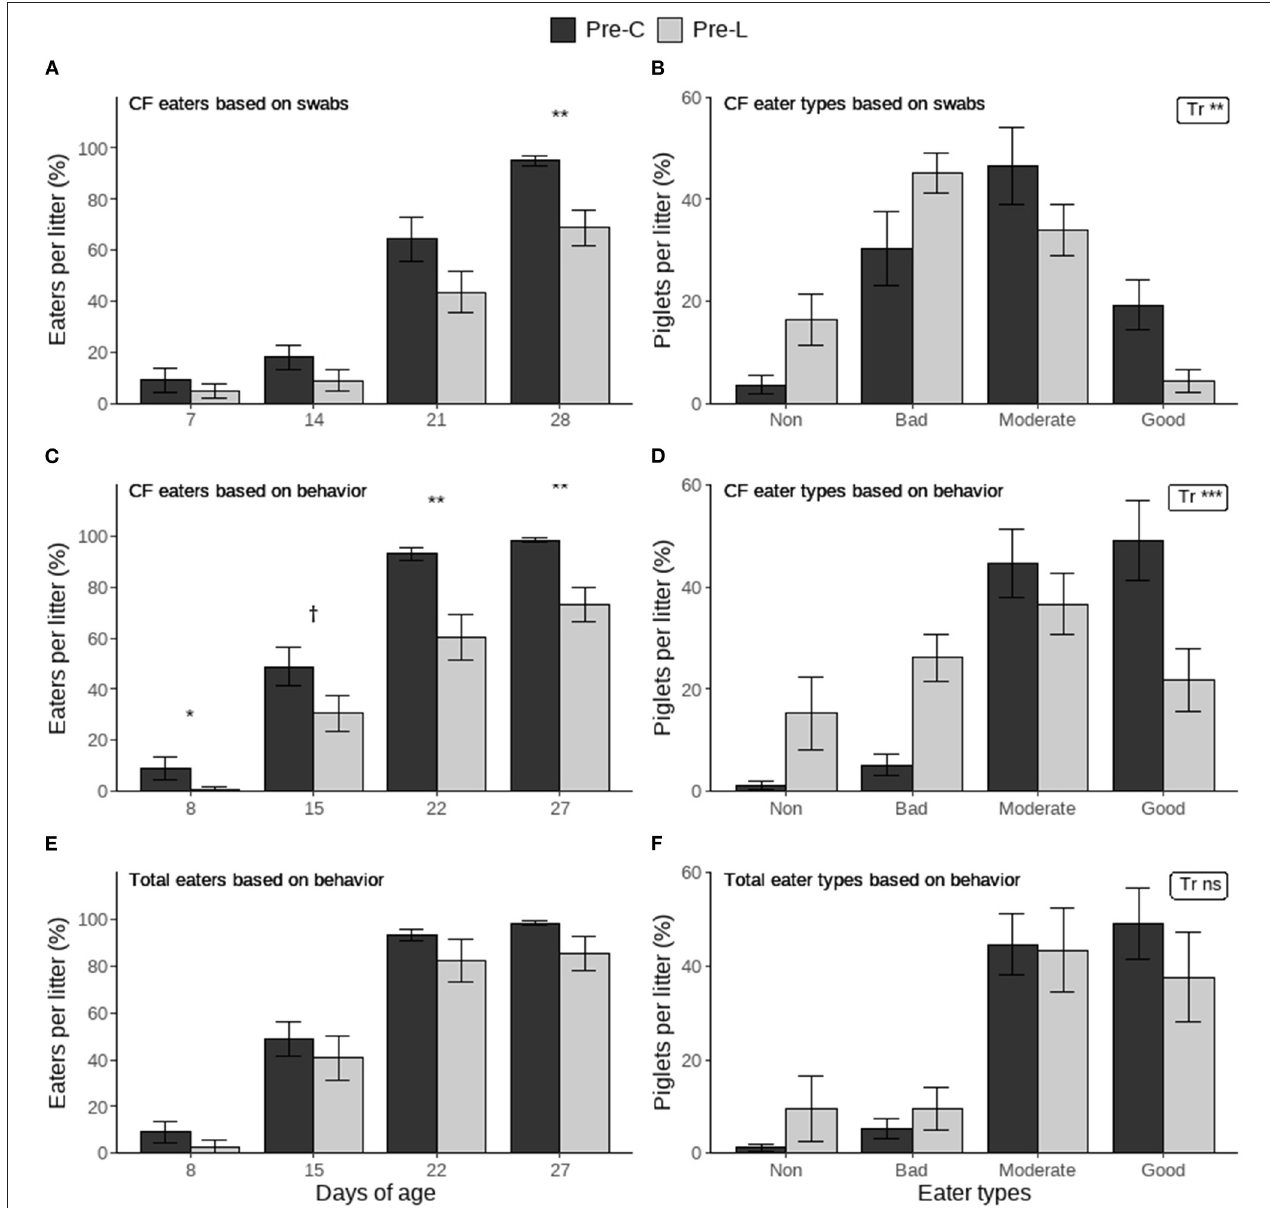
FIGURE 2 | The percentage of piglets per litter that ate creep feed (CF) or creep feed and/or larvae (Total) per day and individual eater types determined at the end of the pre-weaning period based on blue colored rectal swabs or pre-weaning home pen behavioral observations. Piglets had access to either only creep feed (Pre-C) or creep feed and live black soldier fly larvae (Pre-L). For the percentage of eaters (per day) and for the eater types (distribution of all types) the treatment effect is indicated as † ( p < 0.1), *( p < 0.05), **( p < 0.01), ***( p < 0.001) or ns (not significant). Data are presented as pen means ± SEM.